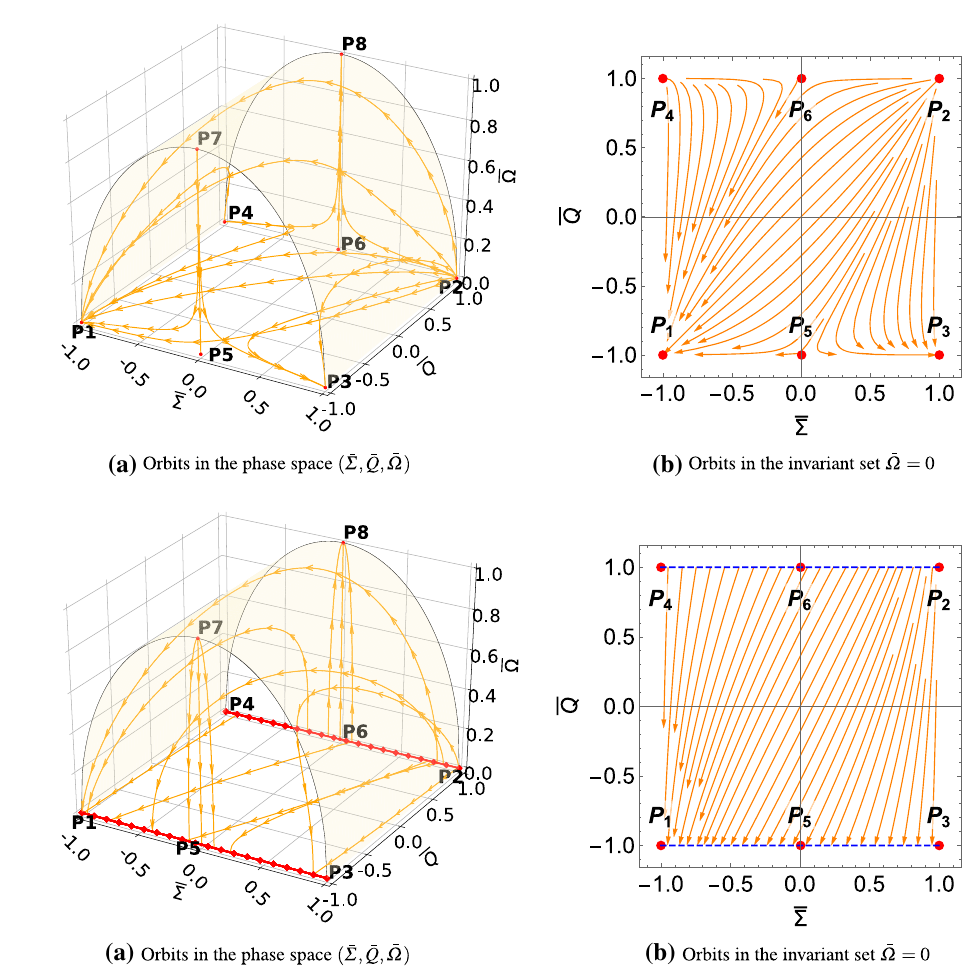
Fig. 5 Phase space of the guiding system (127a)–(127c) corresponding to KS for γ = 4